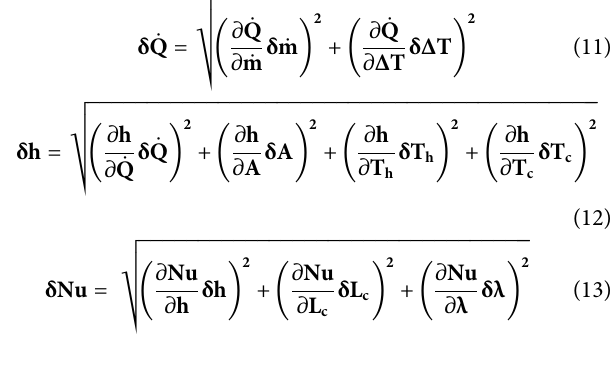
Frontiers in Energy Research |